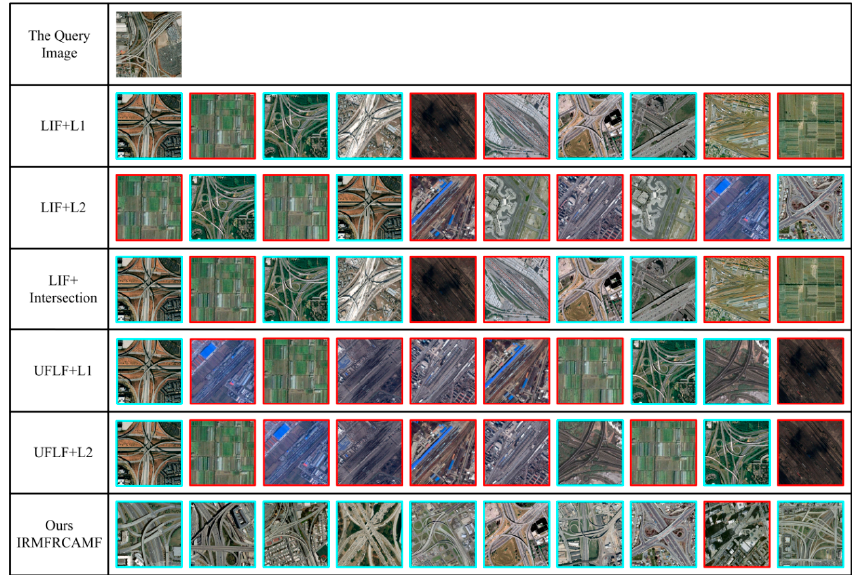
Figure 14. Visual illustration of the retrieved images using different methods when the query image comes from the viaduct class. The red rectangles indicate incorrect retrieval results, and the blue rectangles indicate correct retrieval results. Table 13. Training times of the proposed unsupervised feature learning neural networks.